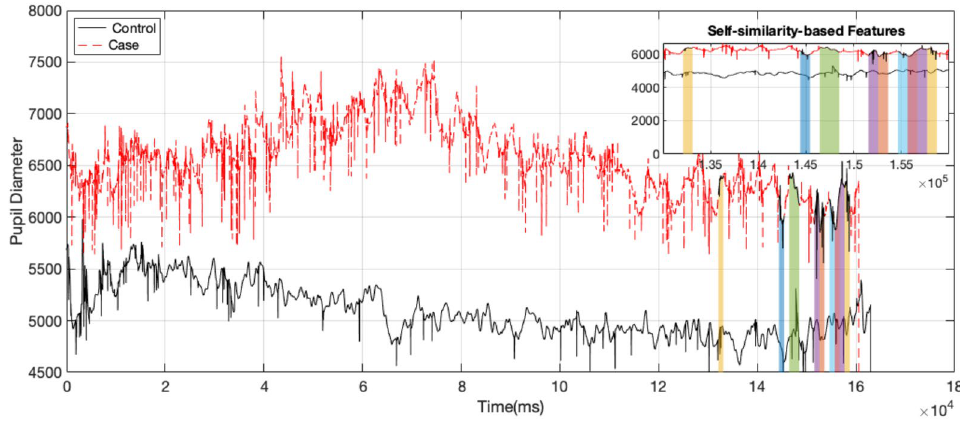
Figure 7. An example pupil diameter signal selected from the normal and ADHD-diagnosed (without medication) group, and the most discriminatory features selected by the self-similarity-based